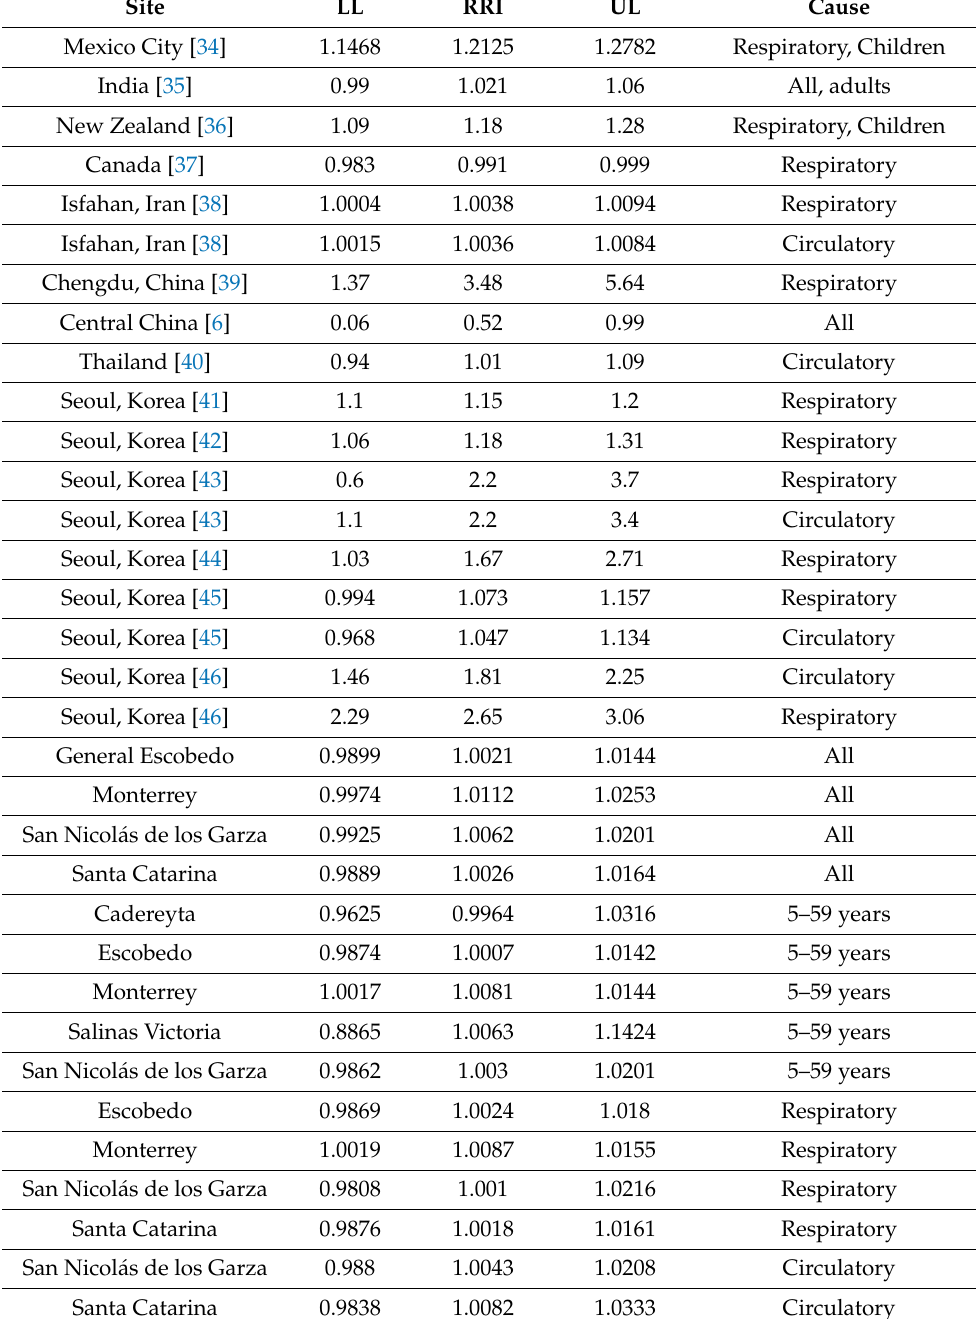
Table 4. RRI, lower and upper limit values found in MAM for NO 2 during the study period, and comparison with values reported by other studies around the